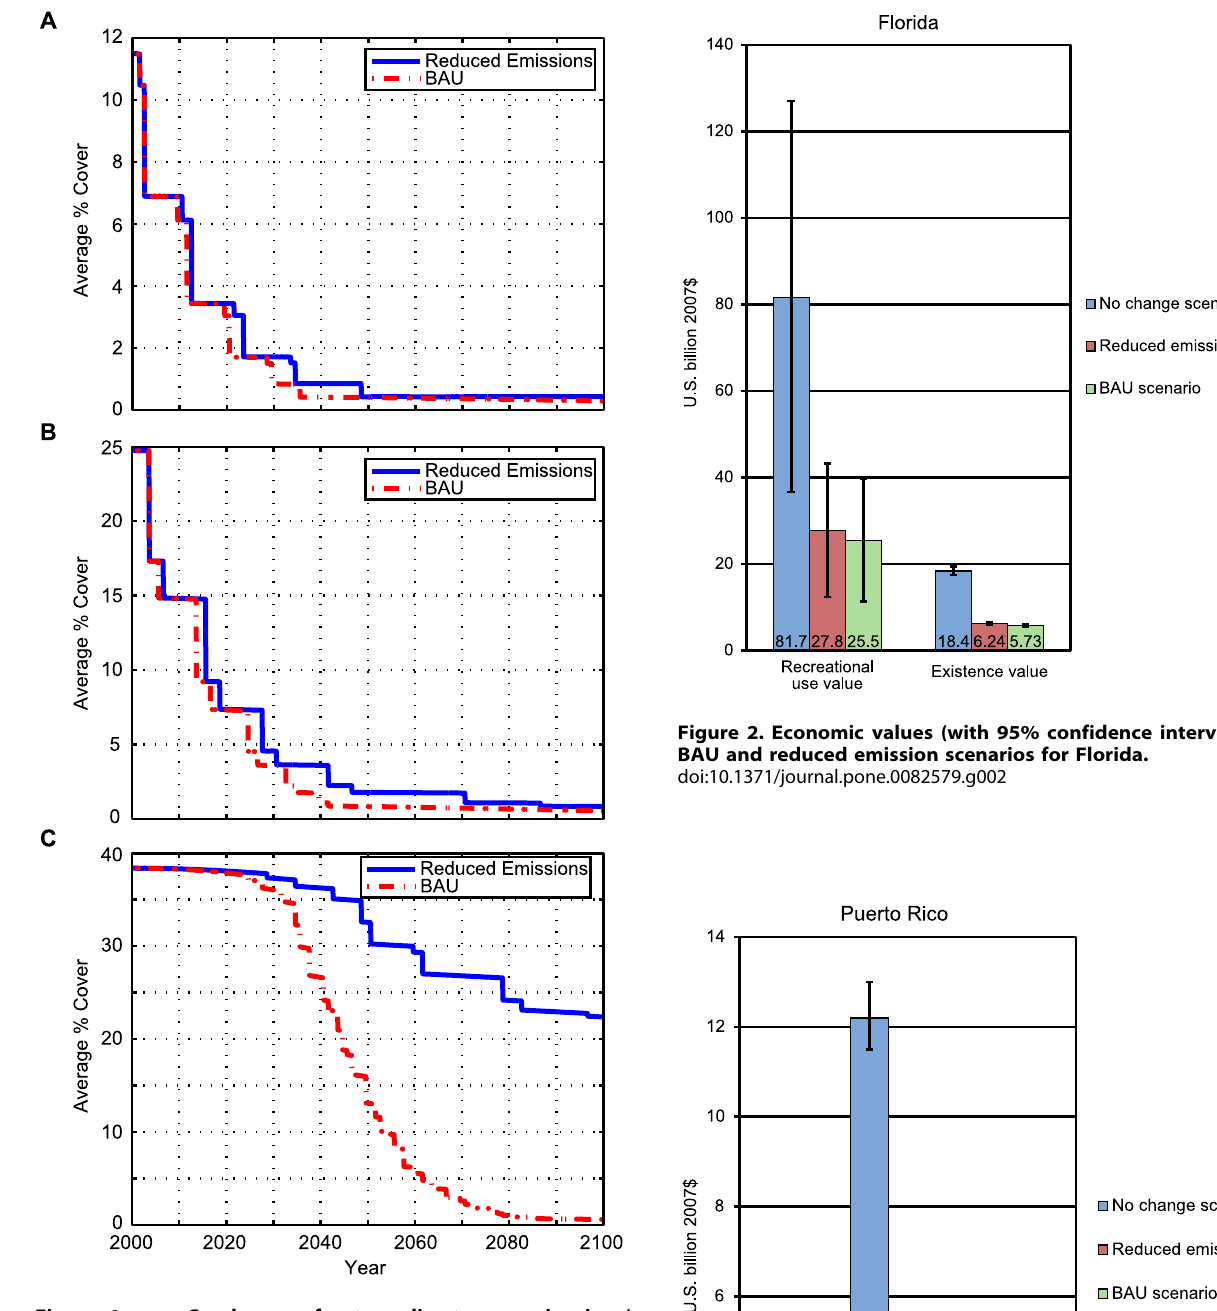
doi:10.1371/journal.pone.0082579.g001